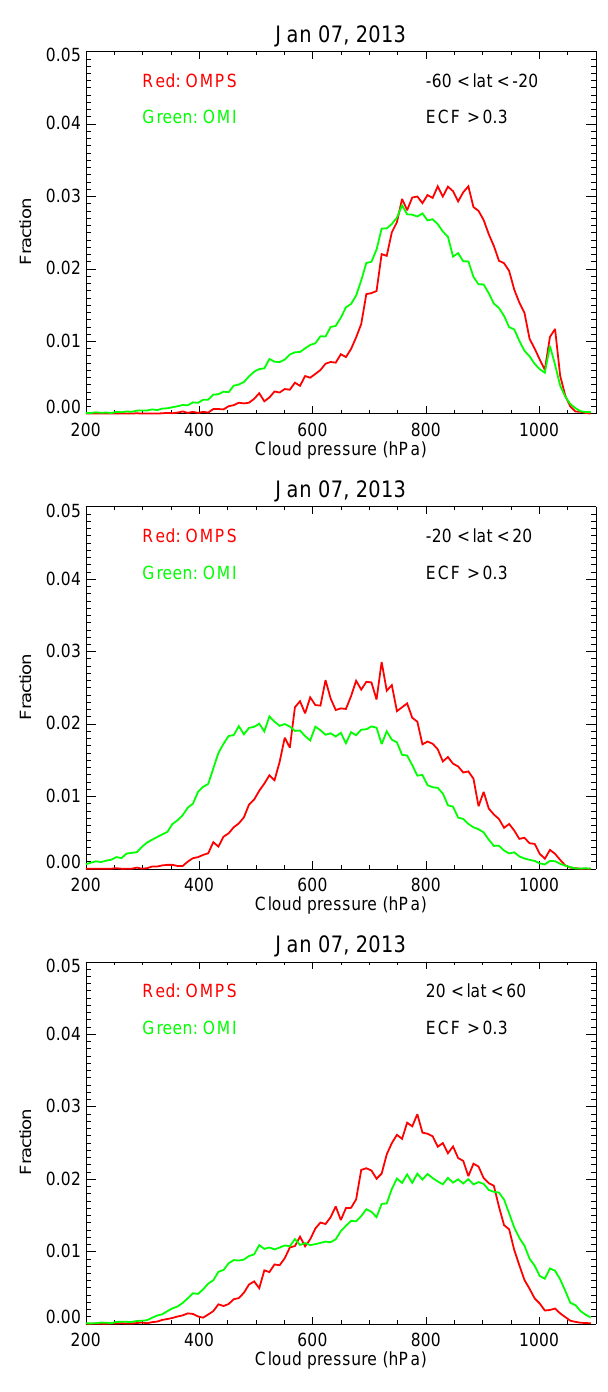
Figure 6. Probability density functions of OMPS and OMI cloud pressures for three latitude bins: southern mid-latitudes (top), trop- ics (middle), and northern mid-latitudes (bottom). We ran an additional experiment using a version of the OMPS level 1b data with a proposed stray light